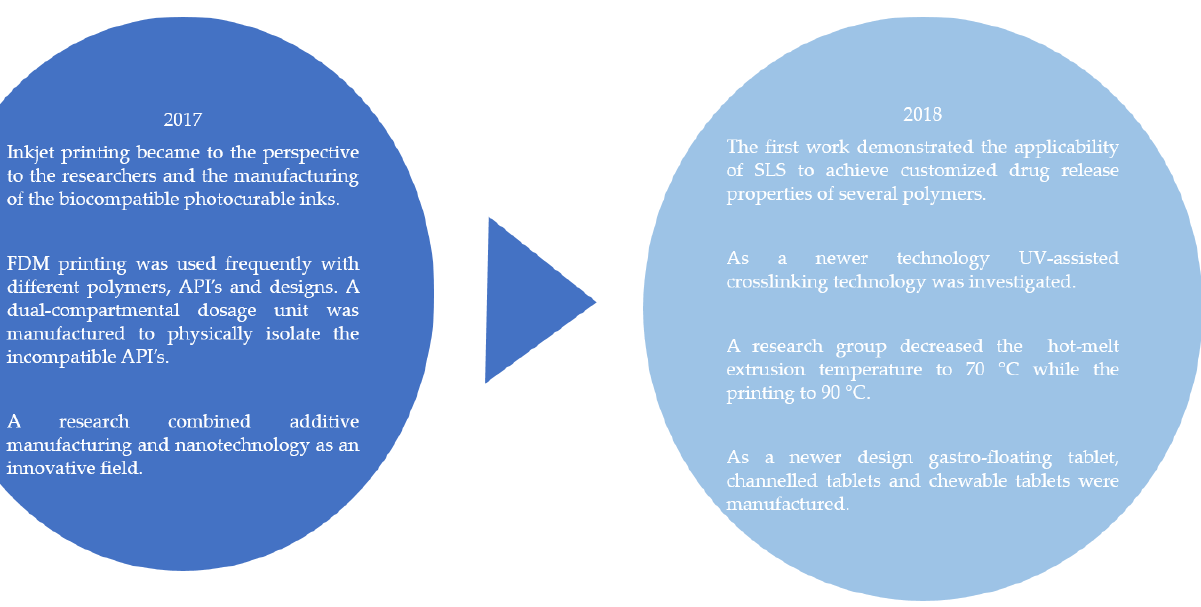
Figure 9. Flow chart of the described tablet manufacturing methods and main breakthroughs in 2017 and 2018.